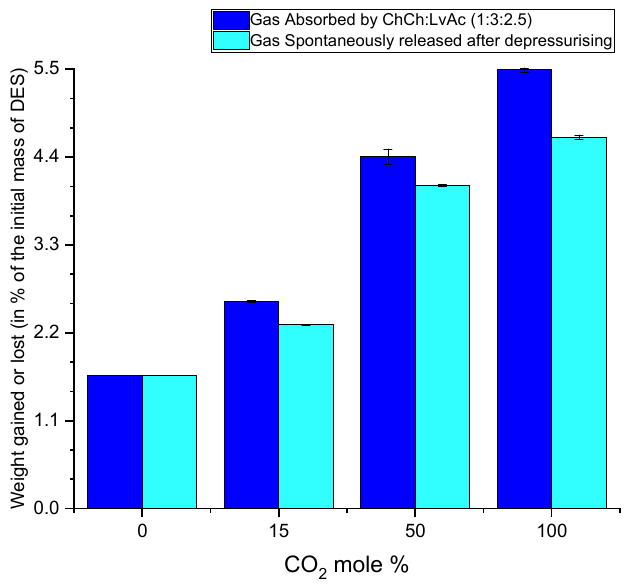
Figure 18. Weight gained by ChCl:LvAc (1:3:2.5) after gas absorption at 25 °C and 250 rpm, and lost by the spontaneous release of gas after depressurisation.